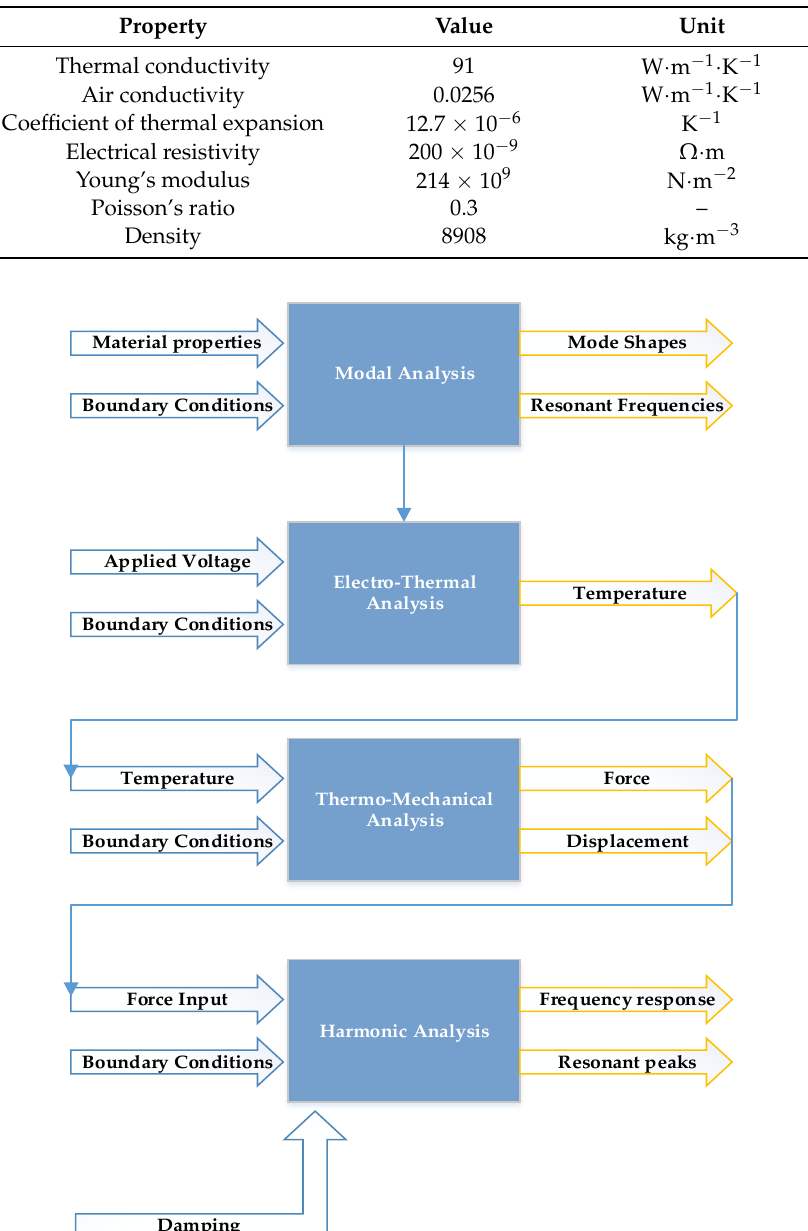
Figure 13. The sequential diagram for the FEM-based